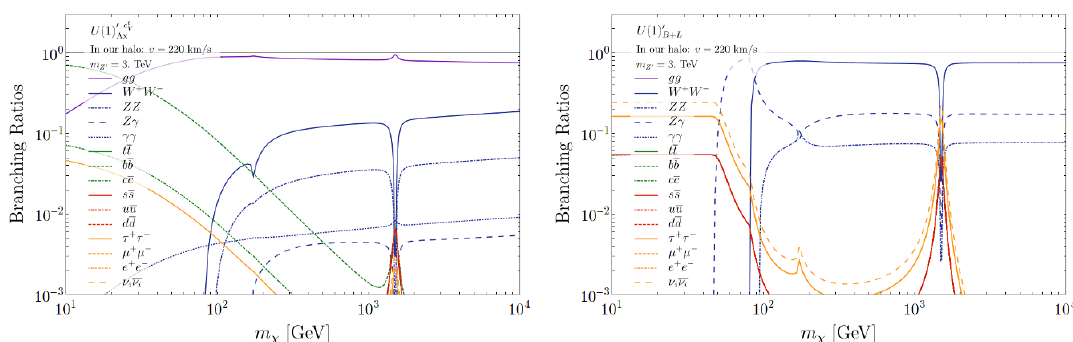
t Figure 4 . Left: DM mass vs. annihilation branching ratios in the U(1) 0 c V ax model. The DM velocity is taken to be 220 km/s, characteristic of the Milky Way halo. The curves are colored as in (cid:12)gure 3. Right: same for the U(1) 0 model. The quark lines all overlap on the red line. The branching B + L ratios of the U(1) 0 model are analogous to the ones of U(1) 0 , without the quark L B + L